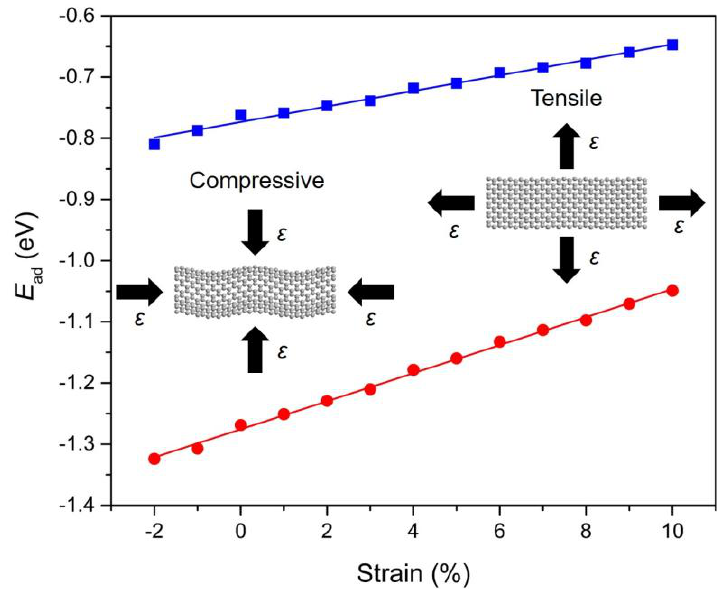
Figure 6. The correlation between the calculated adsorption energies ( E ad ; in eV) and the strain conditions ( ε ) for Ace (blue) and InP (red) adsorbed onto Gr. The blue and red straight lines are linearly fitted to the DFT calculated data points. The screenshots of Gr under compressive and tensile strains are illustrated as insets.